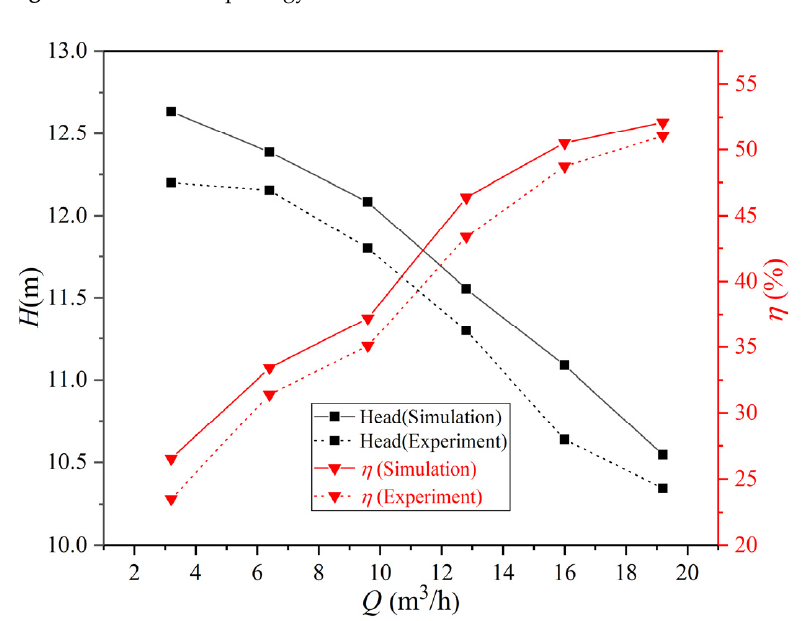
Figure 7. External characteristic verification of centrifugal pump.